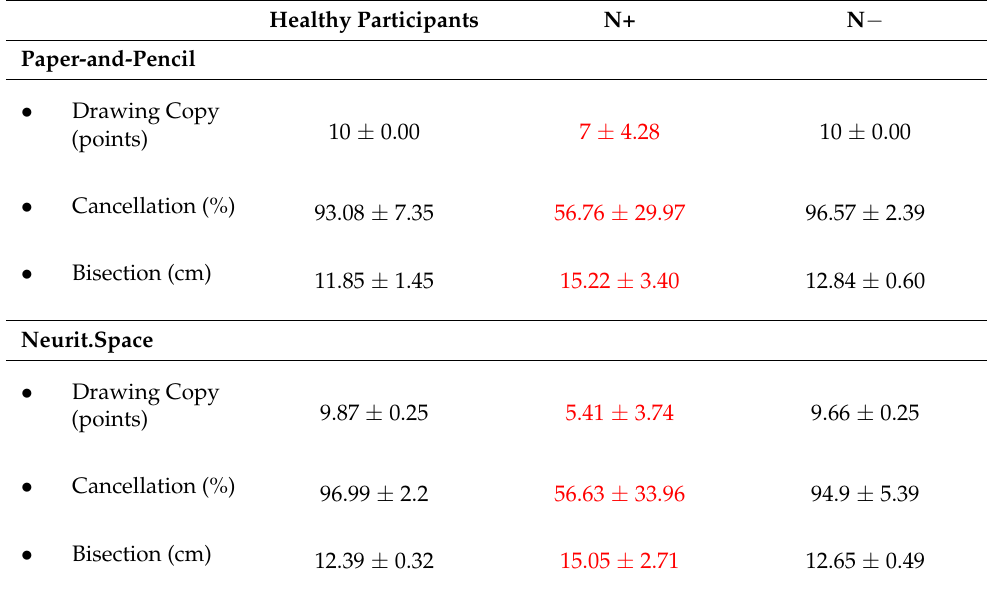
Table 2. Means (M) and standard deviations (SD) of the performances of healthy participants and pa- tients with USN (N+) and without USN (N − ) in the papery and digital tests. M of N+ patients ± 2 SD, compared with the healthy participants’ M, are highlighted in red.